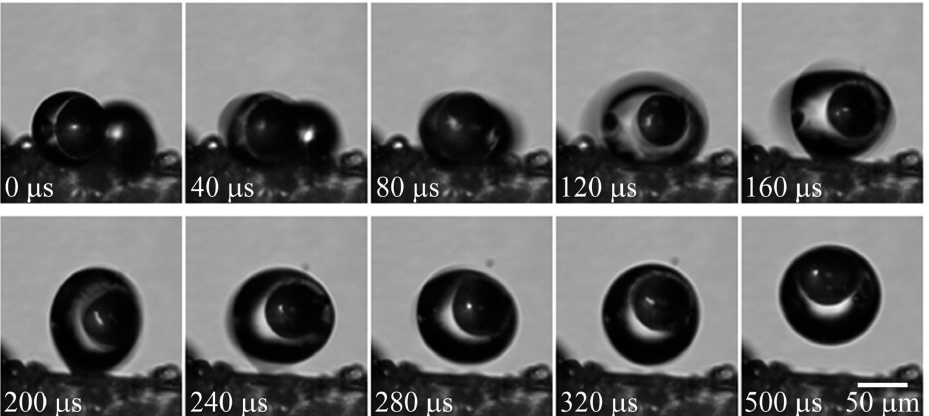
Figure 4. Water vapor condenses and spontaneously jumps off a cicada wing surface, encapsulating 50 µm glass beads. Reproduced with permission from [61], published by PNAS,